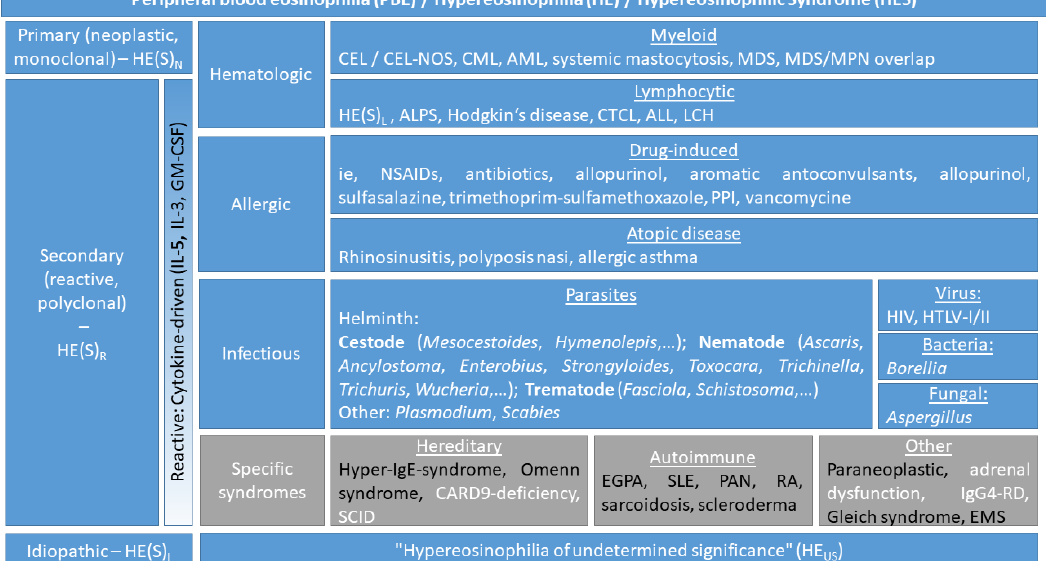
Figure 1. Proposed overview and classification of eosinophilic disorders. Certain specific syndromes (grey boxes) in which the role of eosinophils in the disease mechanism are unclear should be differentiated from ‘real’ HES, according to the International Cooperative Working Group on Eosinophil Disorders (ICOG-EO) proposal (diseases in black letters are explicitly declared as such [2]). Different diseases leading to increased eosinophilic counts are sub-divided into hematologic, allergic, and infectious disorders, while idiopathic hypereosinophilic syndrome is separated from primary and secondary forms. IL, interleukin; GM-CSF, granulocyte-macrophage colony-stimulating factor; HE(S) M , myeloid HE(S); HE(S) L , lymphocyte-variant HE(S); CEL, chronic eosinophilic leukemia; NOS,